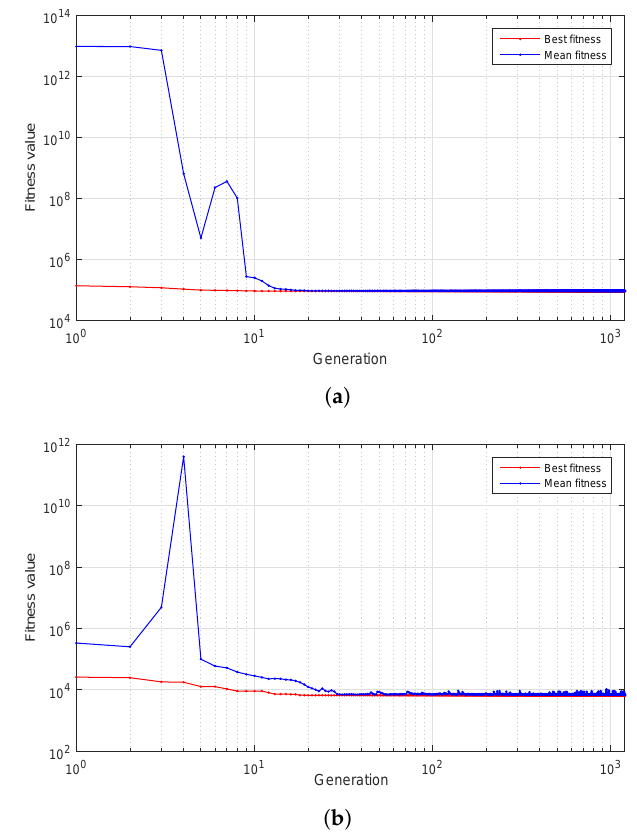
Figure 6. Convergence of the objective function using genetic algorithm ( a ) Lumped parameters model calibrated to full-scale crash test; ( b ) Lumped parameters model calibrated to finite element model.